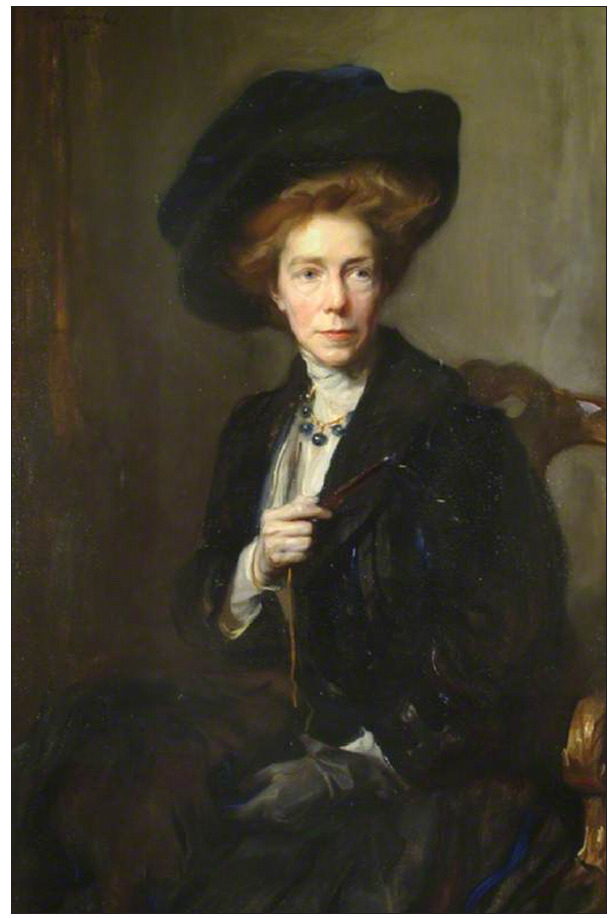
Fig. 8 : Philip Alexius de László, Elizabeth Maude Guinness , 1910, oil on canvas, 101.6 × 76.2 cm, Royal Holloway, University of London,